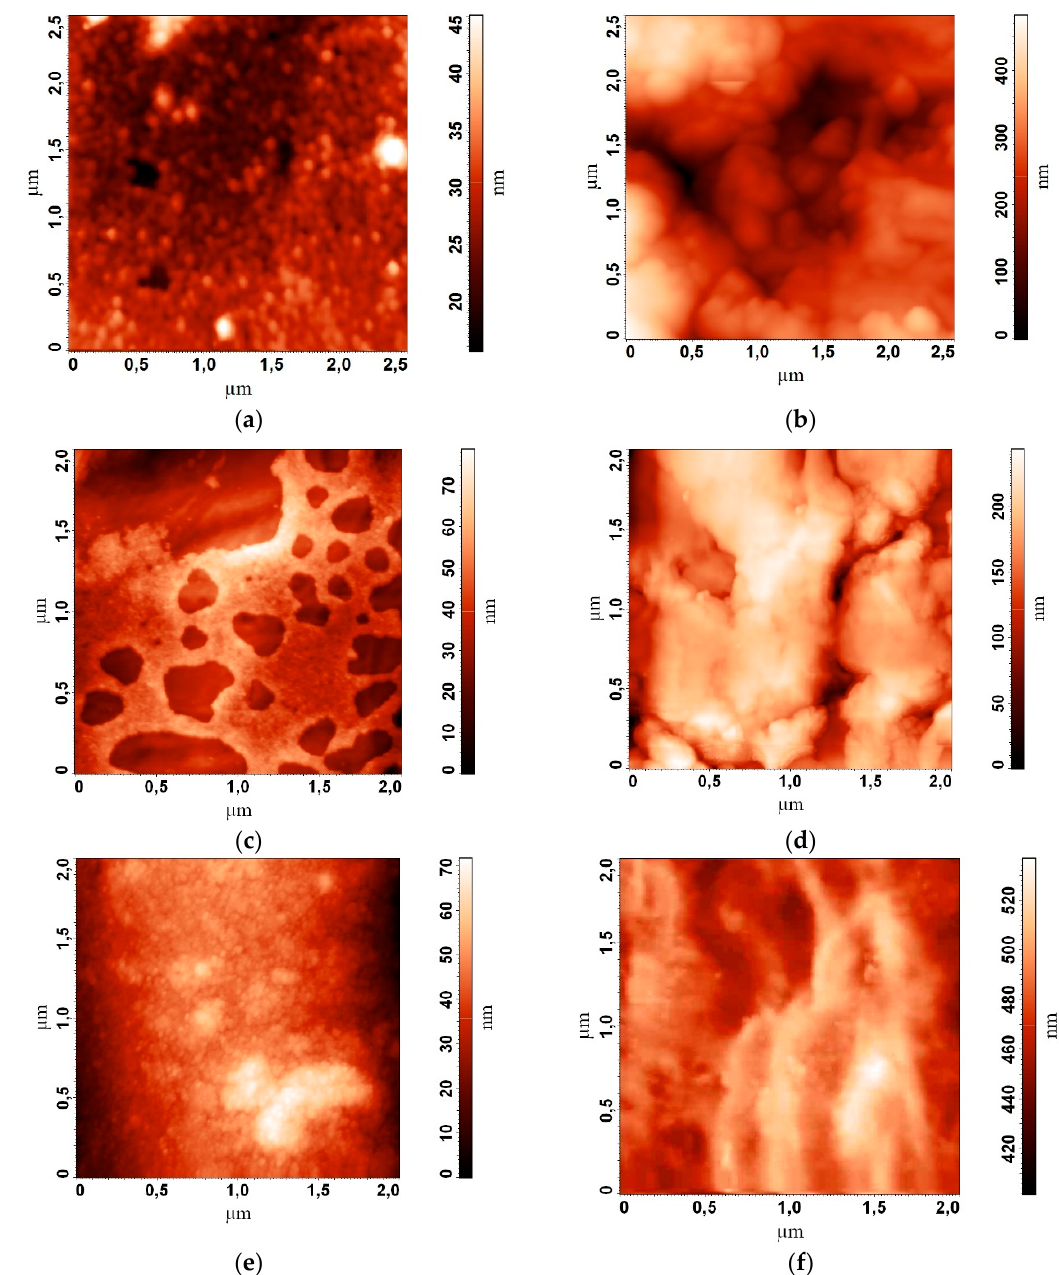
Figure 5. Effect of abrasion on the polyester fibre surface morphology in a fabric modified with TiO 2 nanoparticles doped with iron and silver: ( a ) Coating of undoped TiO 2 ; ( b ) coating of undoped TiO 2 after abrasion; ( c ) coating of TiO 2 doped with iron; ( d ) coating of TiO 2 doped with iron after abrasion; ( e ) coating of TiO 2 doped with silver; ( f ) coating of TiO 2 doped with silver after abrasion. AFM method. The scanning area is 2 μ m × 2 μ m.